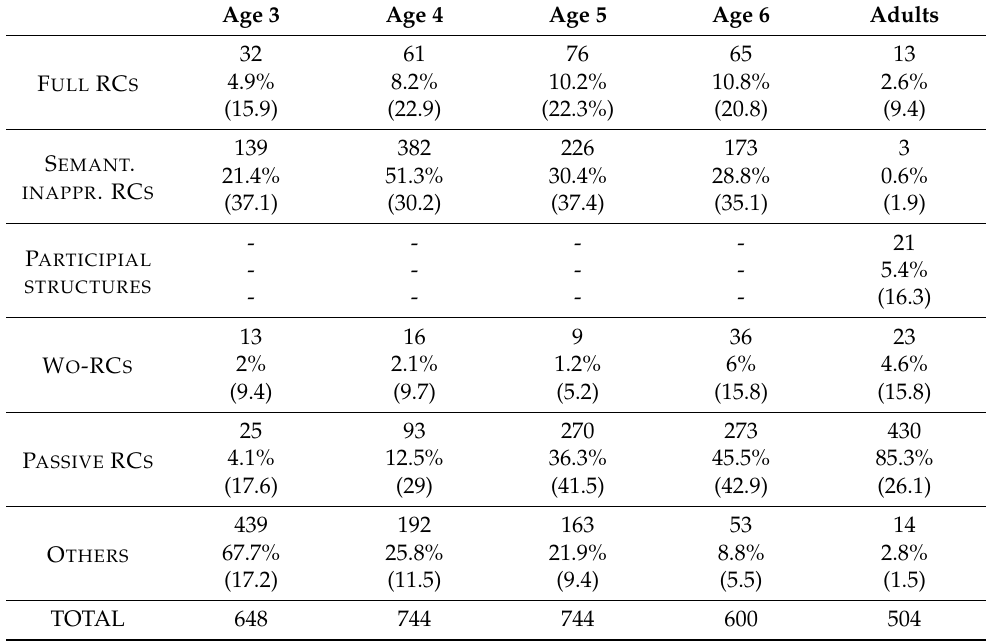
Table 3. Raw scores, percentages (%), and standard deviations (N) of the five structures produced in the patient-modifying condition for each age group.